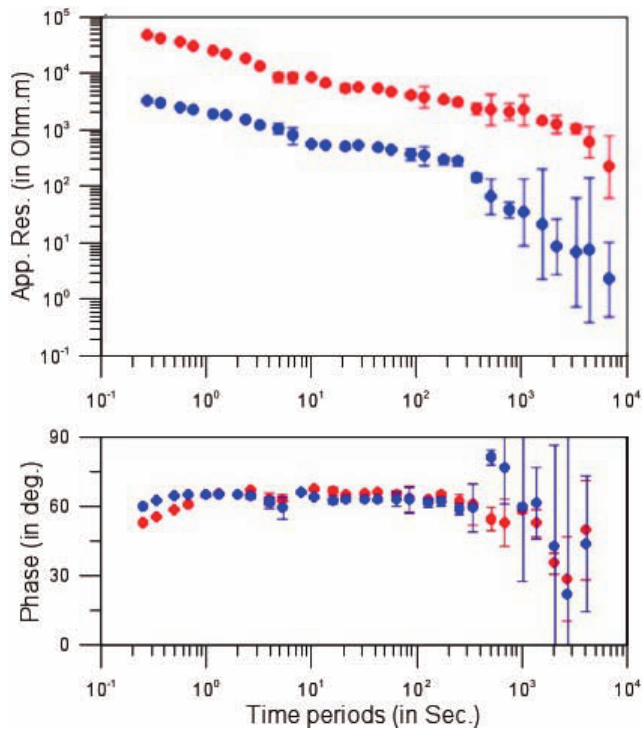
Figure 6. Classic field example showing the apparent resisitivity data (top) and the phase data (bottom) in transverse electric (red) and transverse magnetic (blue) modes with static shift [Dey